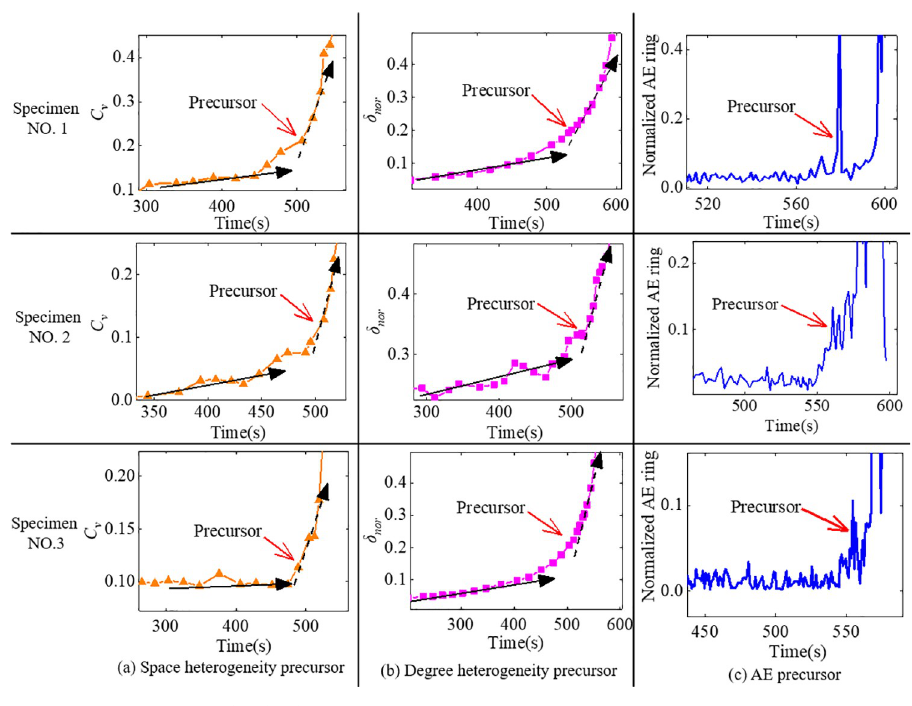
Fig 8. Damage precursors for the three specimens.